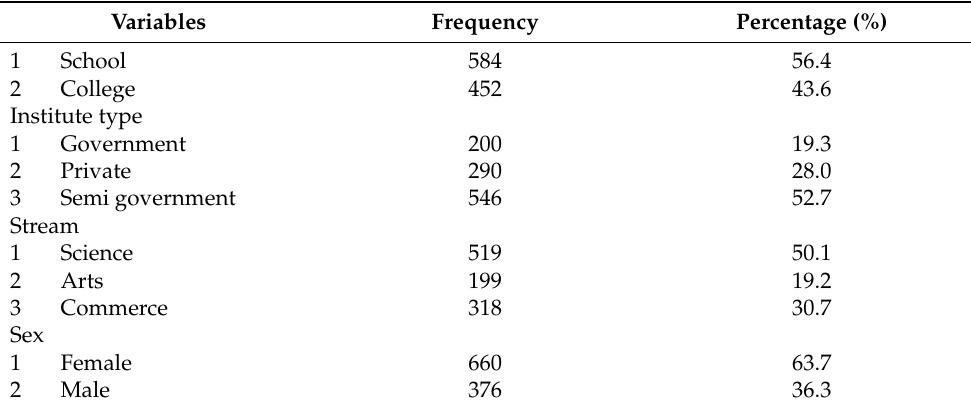
Table 1. Demographic